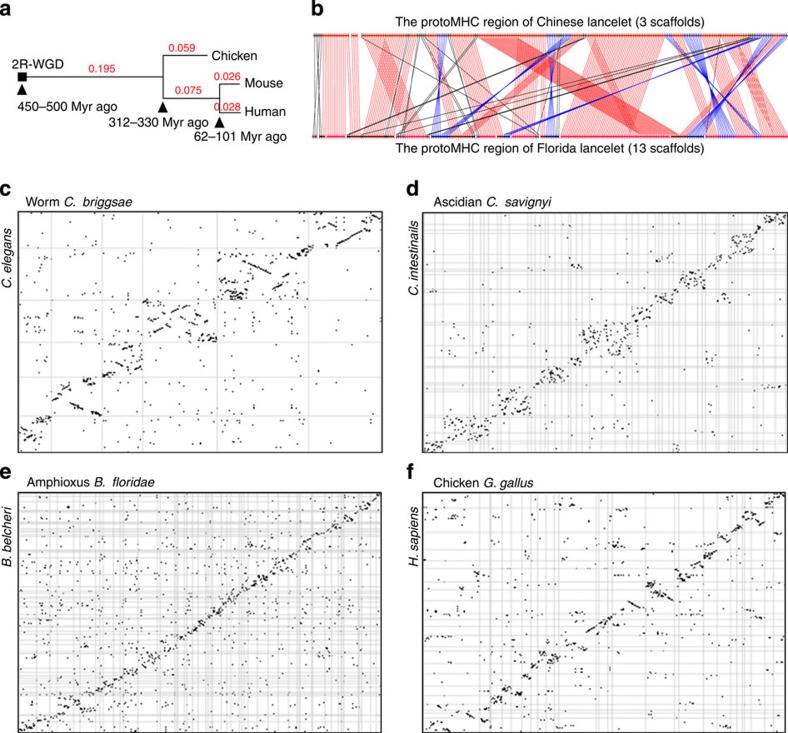
Comparative analysis of gene synteny and rearrangements.(a) A distance tree (DCJ distance) showing that the genome-wide gene rearrangement rates in modern vertebrates (chicken, human and mouse) sharply decreased after the 2R-WGD. (b) Comparison of the gene order in the protoMHC region between the Chinese and Florida lancelets. A total of 269 genes conserved between lancelet and human are shown in the analysis. The DCJ rearrangement rate between the protoMHC regions of the two lancelets is 120/269=0.45, which is almost twice the average genome-wide rate (0.23) between the two lancelets (P<1e−8, χ2-test), indicating highly active local gene order scrambling in the protoMHC region. (c–f) Dot plots of gene synteny and rearrangements between closely related genomes. Scaffolds and chromosomes were bidirectionally clustered according to their similarity in gene synteny conservation. Two additional species pairs (fruit flies and bony fishes) and the high-resolution figures are presented in Supplementary Figs 16–21. More information is provided in Supplementary Note 7.